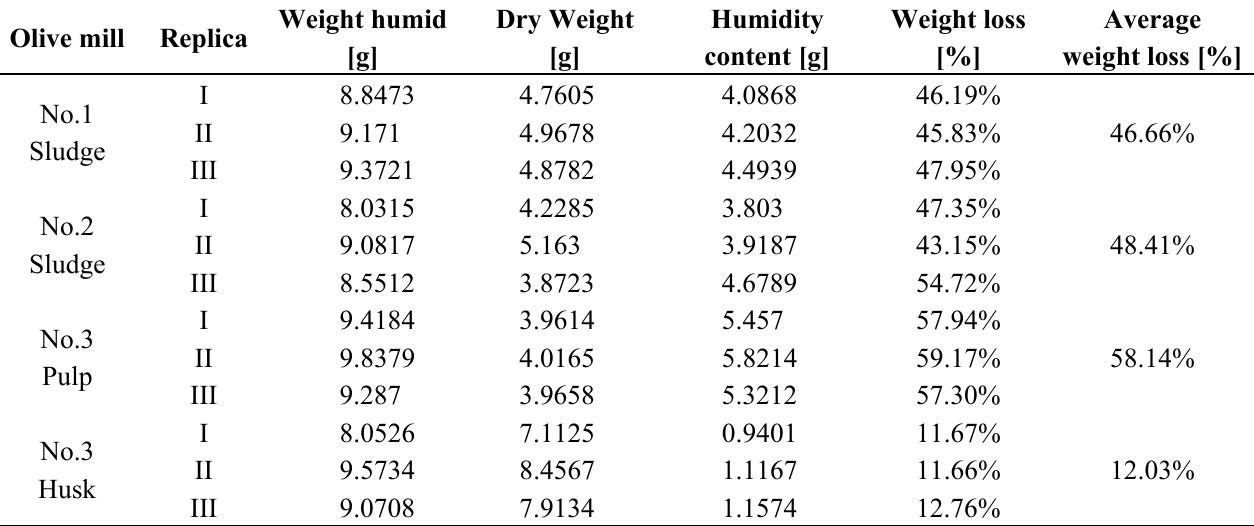
Table 1. Humidity content evaluated per each of the